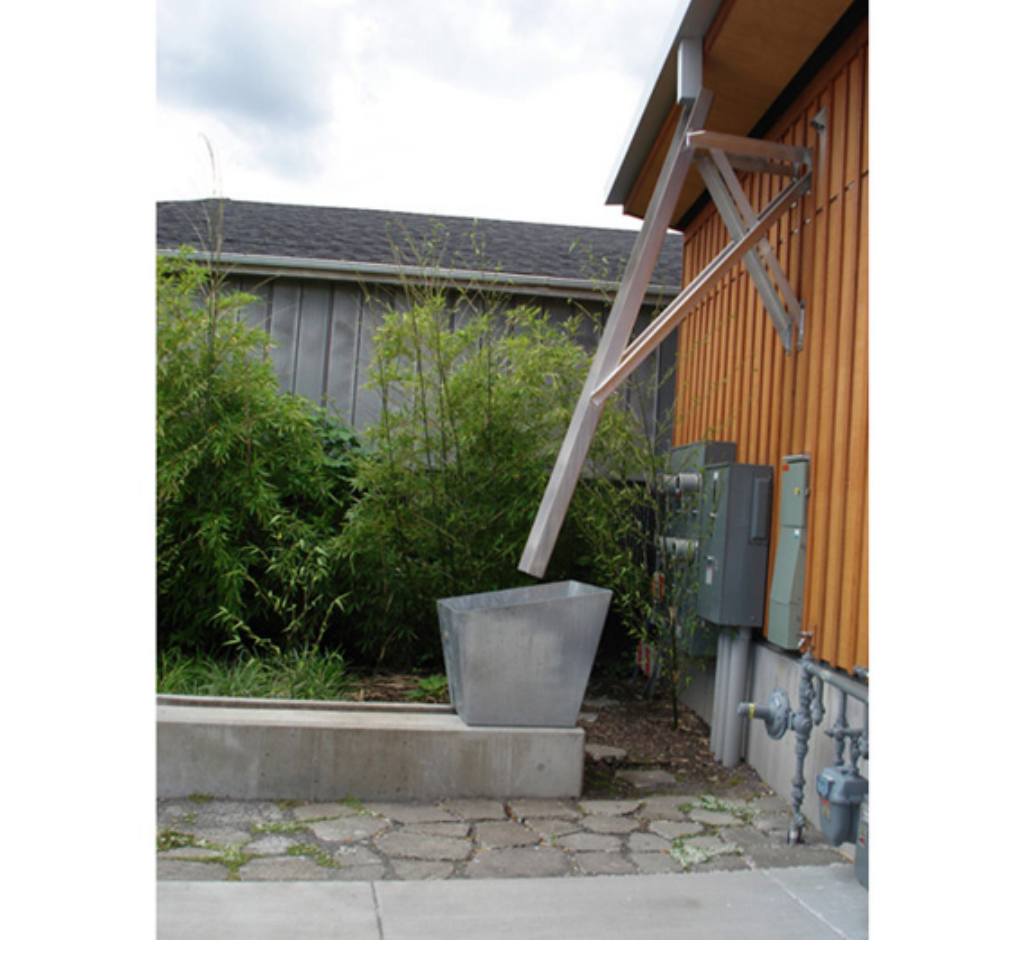
Figure 7. Rainwater from a rooftop is diverted to nearby gardens to support vegetation. This feature also serves an aesthetic function as rainwater creates a